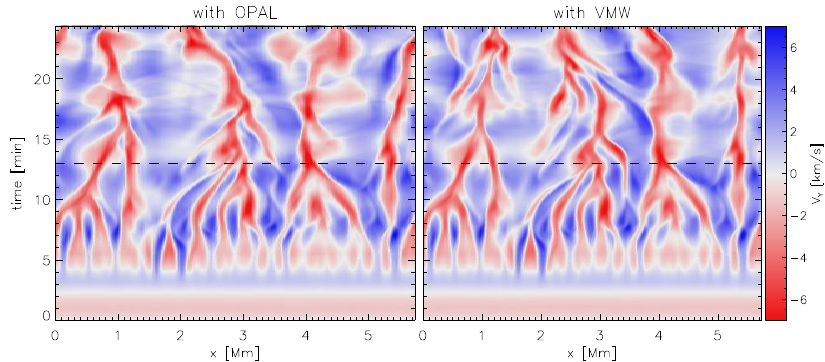
Figure 6. Vertical velocity at fixed height (850km above the bottom of the simulation box) over the first 24min of the simulation with the OPAL EOS (left) and with the VMW EOS (right). The dashed line approximately marks the instance when the two simulation runs